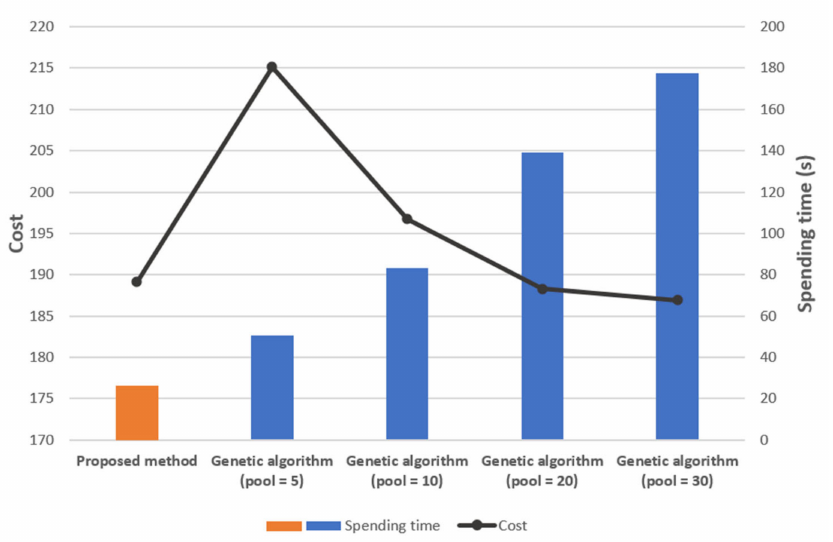
Figure 11. The comparison for the genetic algorithm (average for 5 times) and our methodology for 30 nodes topology in Figure 10